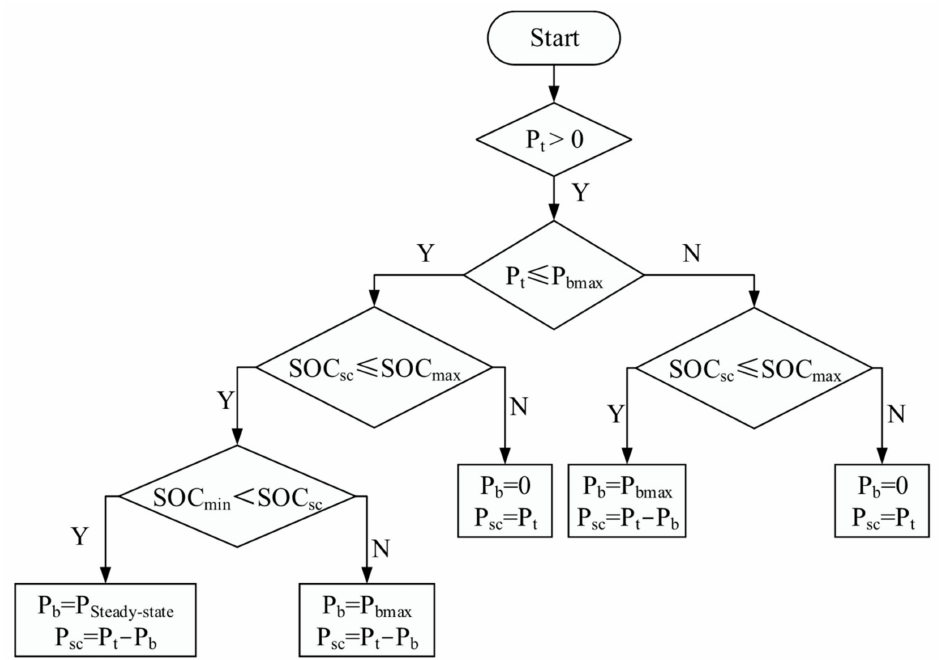
Figure 3. Flow chart of power distribution under driving conditions.